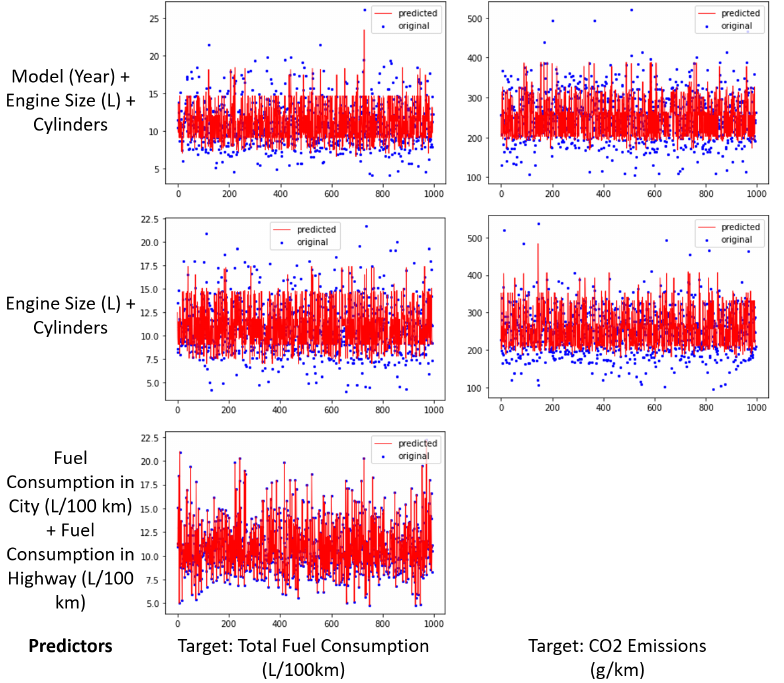
Figure 19. Scatterplot of prediction outputs of Convolutional Neural Network model in different